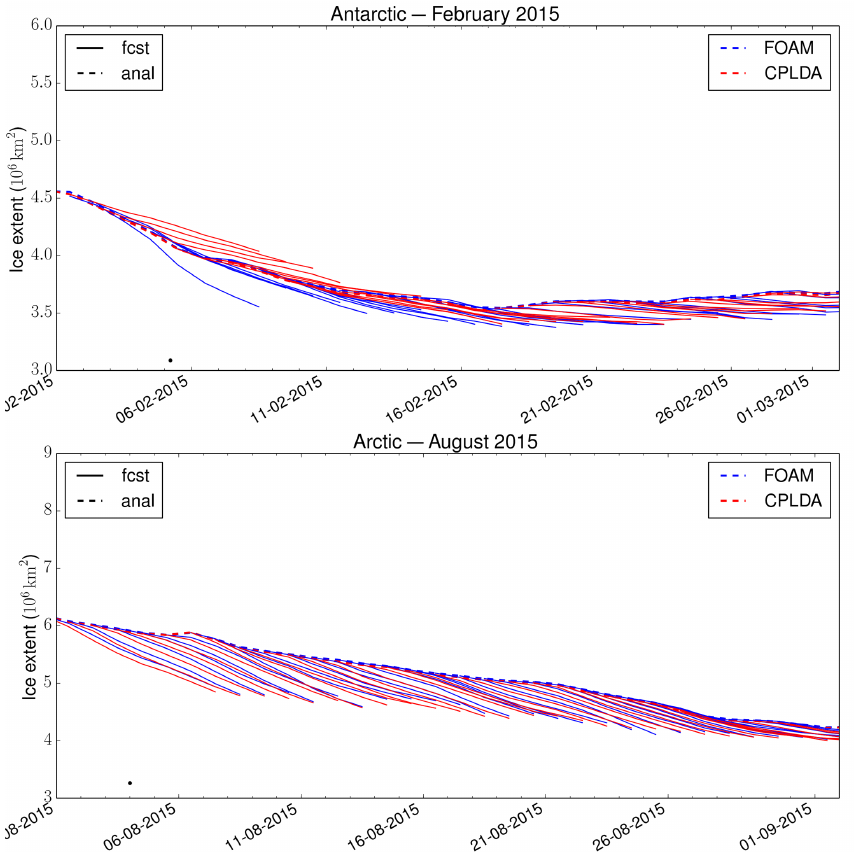
Figure 4. Sea ice extent forecast for CPLDA (2015 experiment) and FOAM during the melting season (February in the Antarctic and August in the